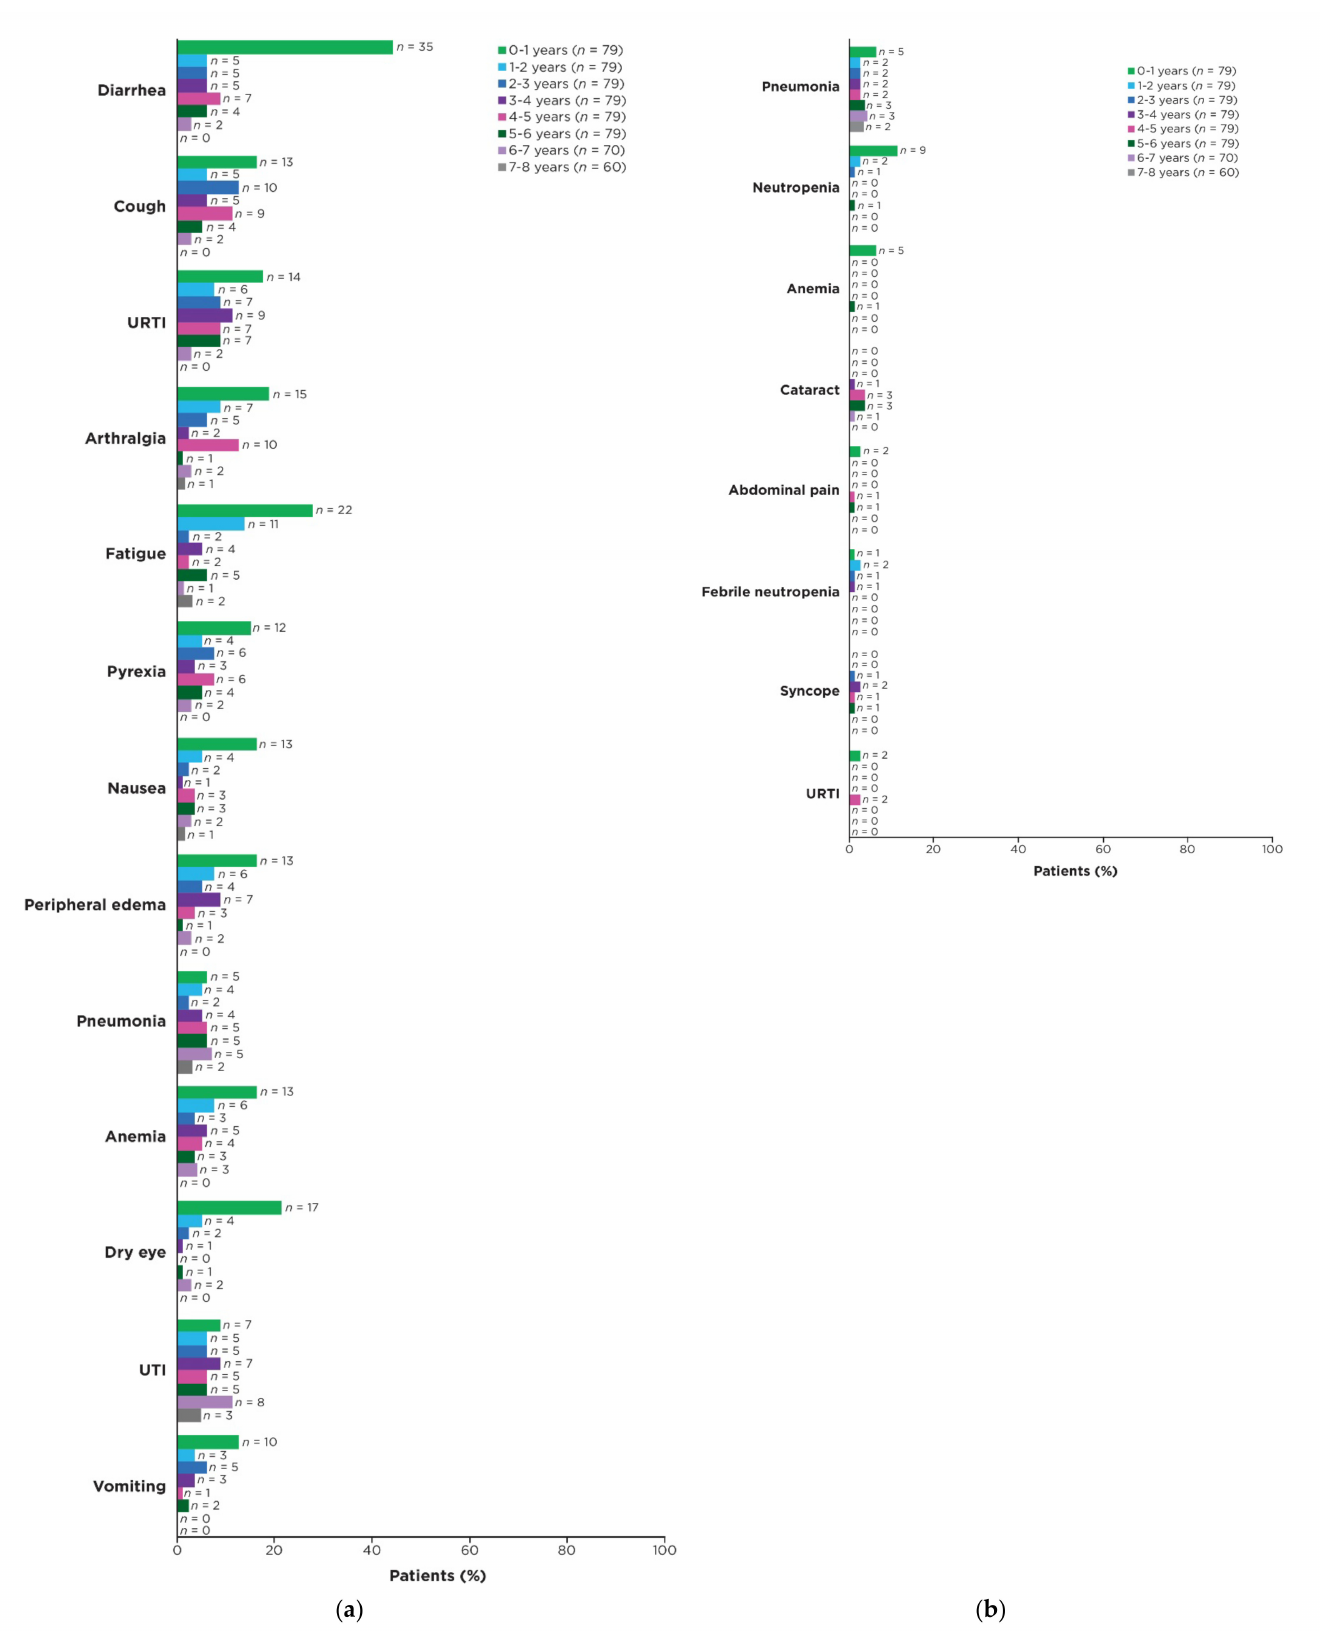
Figure 3. Prevalence of AEs over time in patients on ibrutinib treatment for ≥ 5 years. ( a ) Most